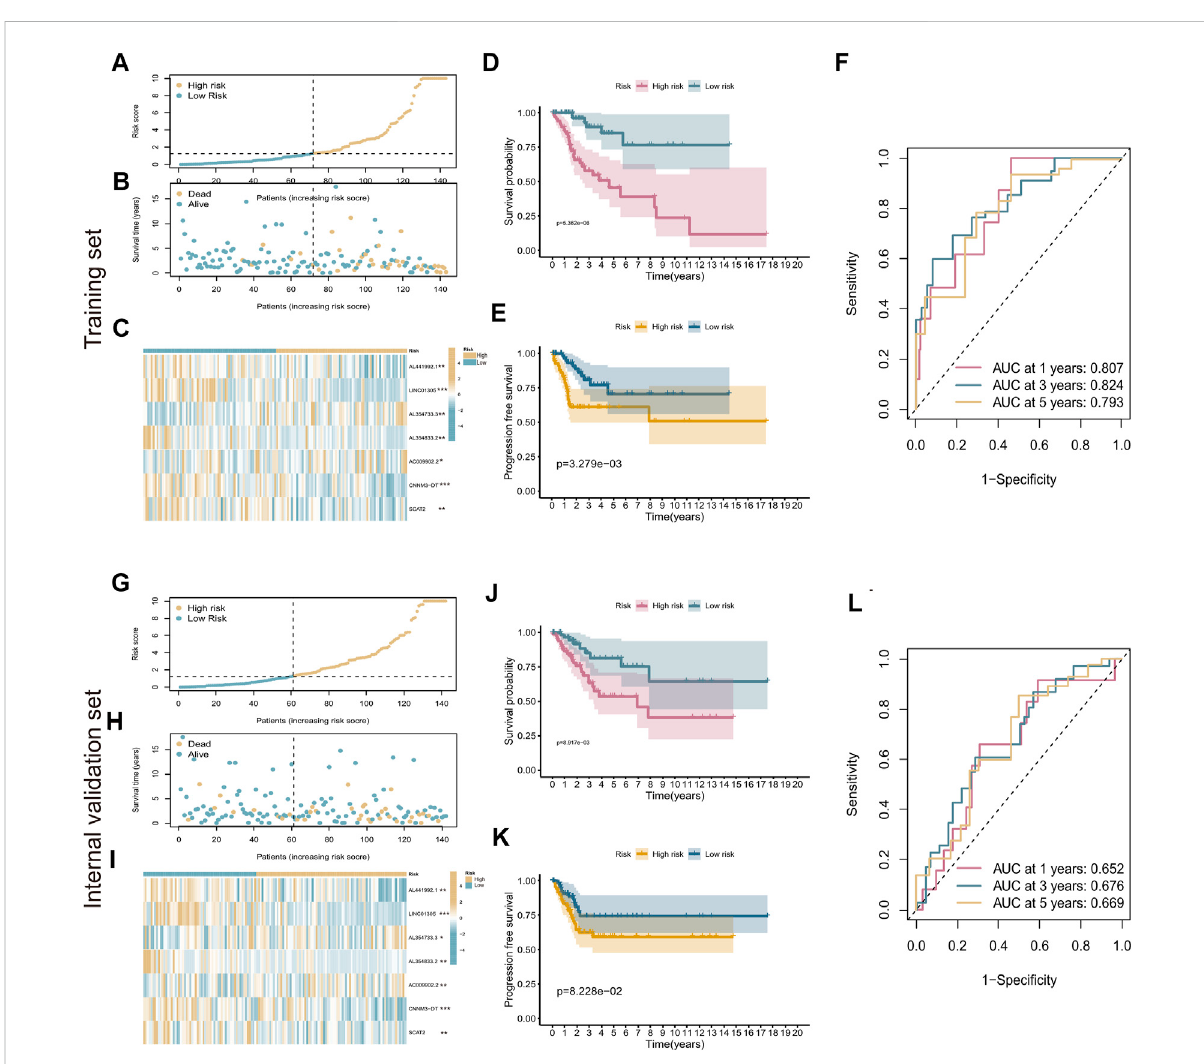
FIGURE 3 Evaluation ofcuproptosis-related seven-lncRNA prognostic signature. (A) Risk curves based ontherisk scores inhigh-risk and low-risk groups. (B) Scatterplotshowingeachpatient ’ ssurvivalstatus.Bluerepresentssurvival,yellowrepresentsdeath. (C) Heatmapshowingtheexpressionlevelsof cuproptosis-related lncRNAs in high-risk and low-risk groups. (D,E) Kaplan – Meier survival analysis showing the difference in patient prognosis between the high-risk and low-risk groups with respect to OS (D) and PFS (E) . (F) Time-dependent ROC curves for 1-, 3-, and 5-year OS. (G – L) Evaluation of the prognostic ability of the signature in the internal validation set. * p < 0.5; ** p < 0.01; *** p <